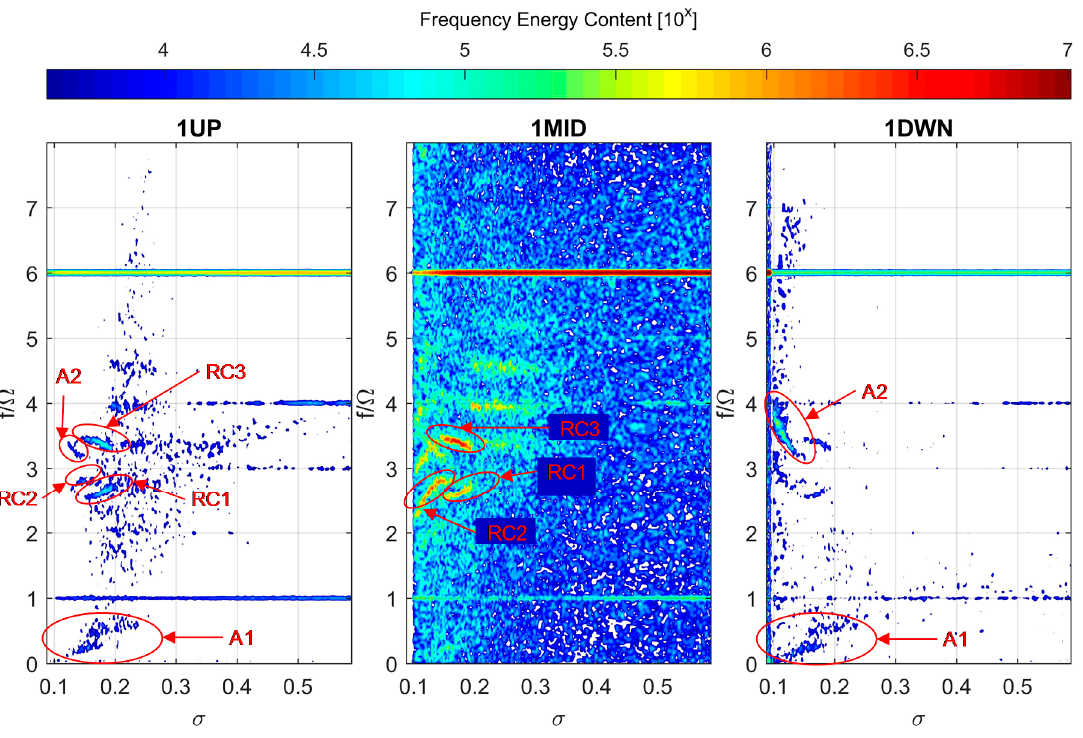
Table 8. Summary of the found instabilities at Φ (cid:3015) = 0.108. Abbreviations: RC, rotating cavitation; A, axial.